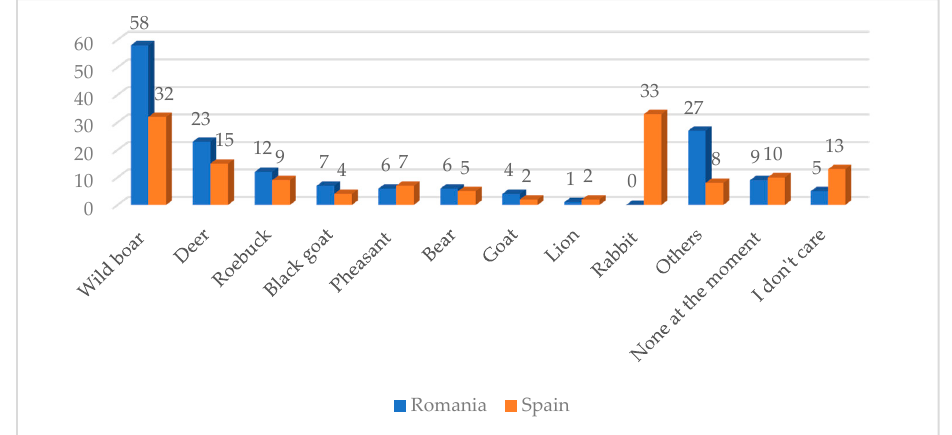
Figure 3. Trophy hunting.